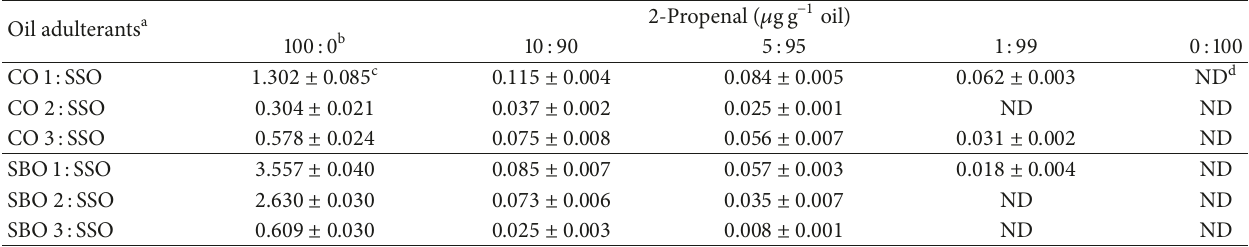
Table 5: Concentrations of 2-propenal in corn, soybean, sesame, and adulterated sesame oils. Oil adulterants